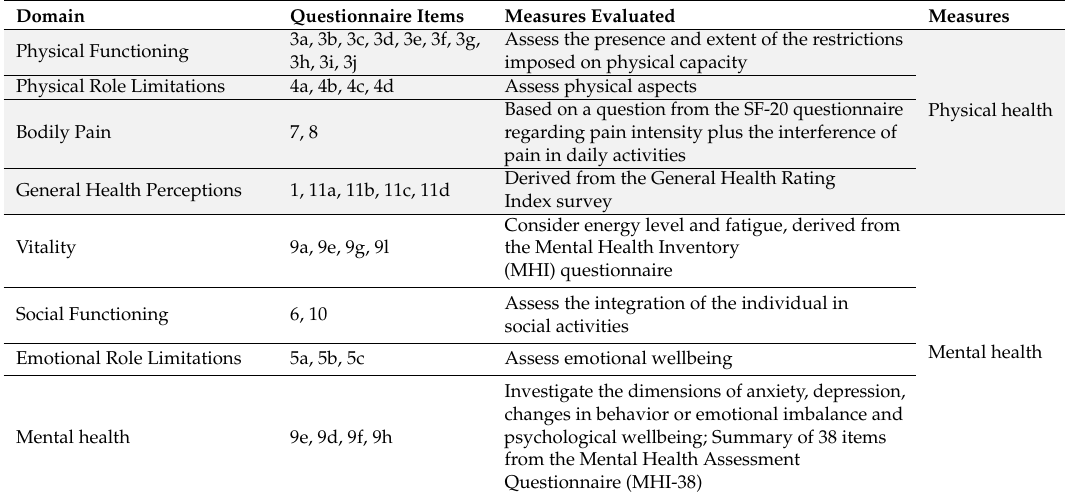
Table 1. Description of domains from the SF-36v01